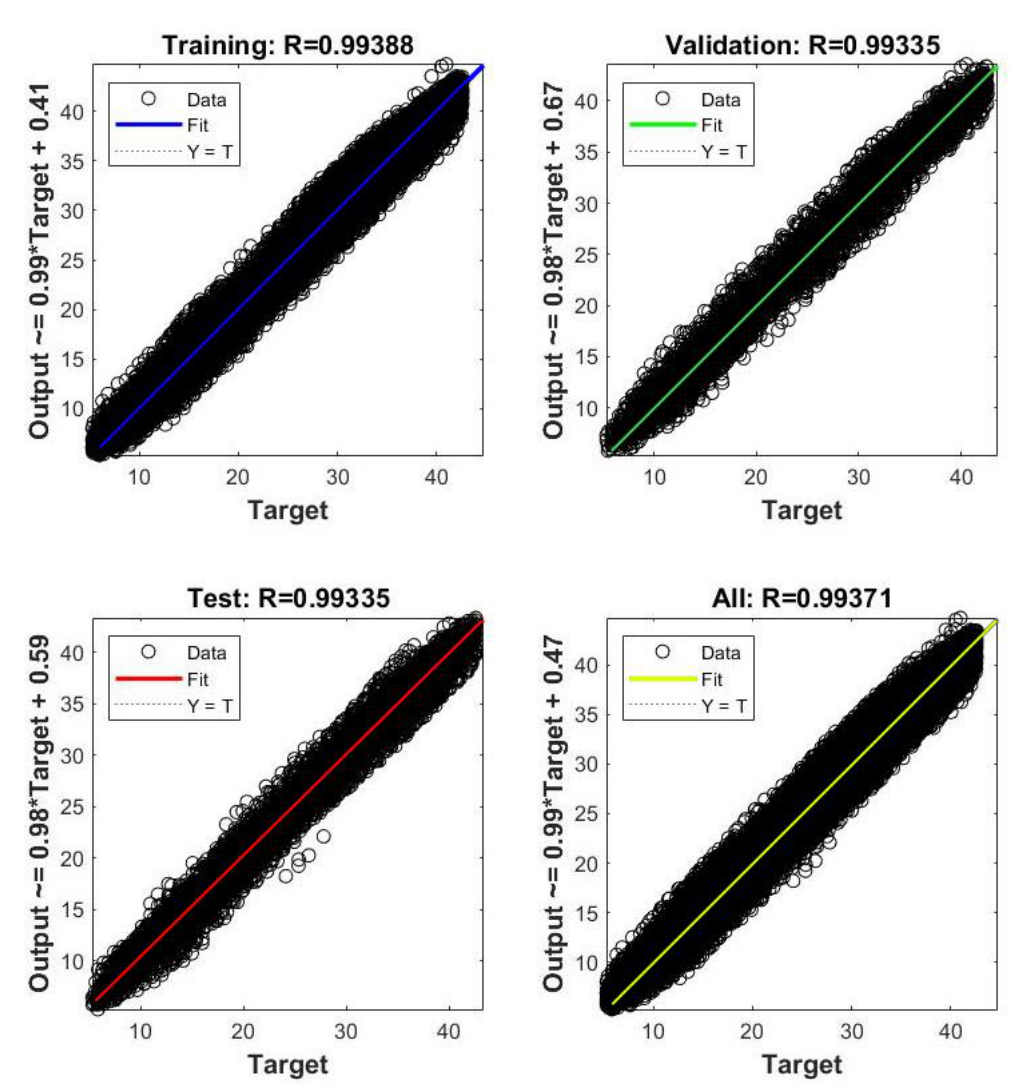
Figure 8. Back propagation neural network R at time step 0.